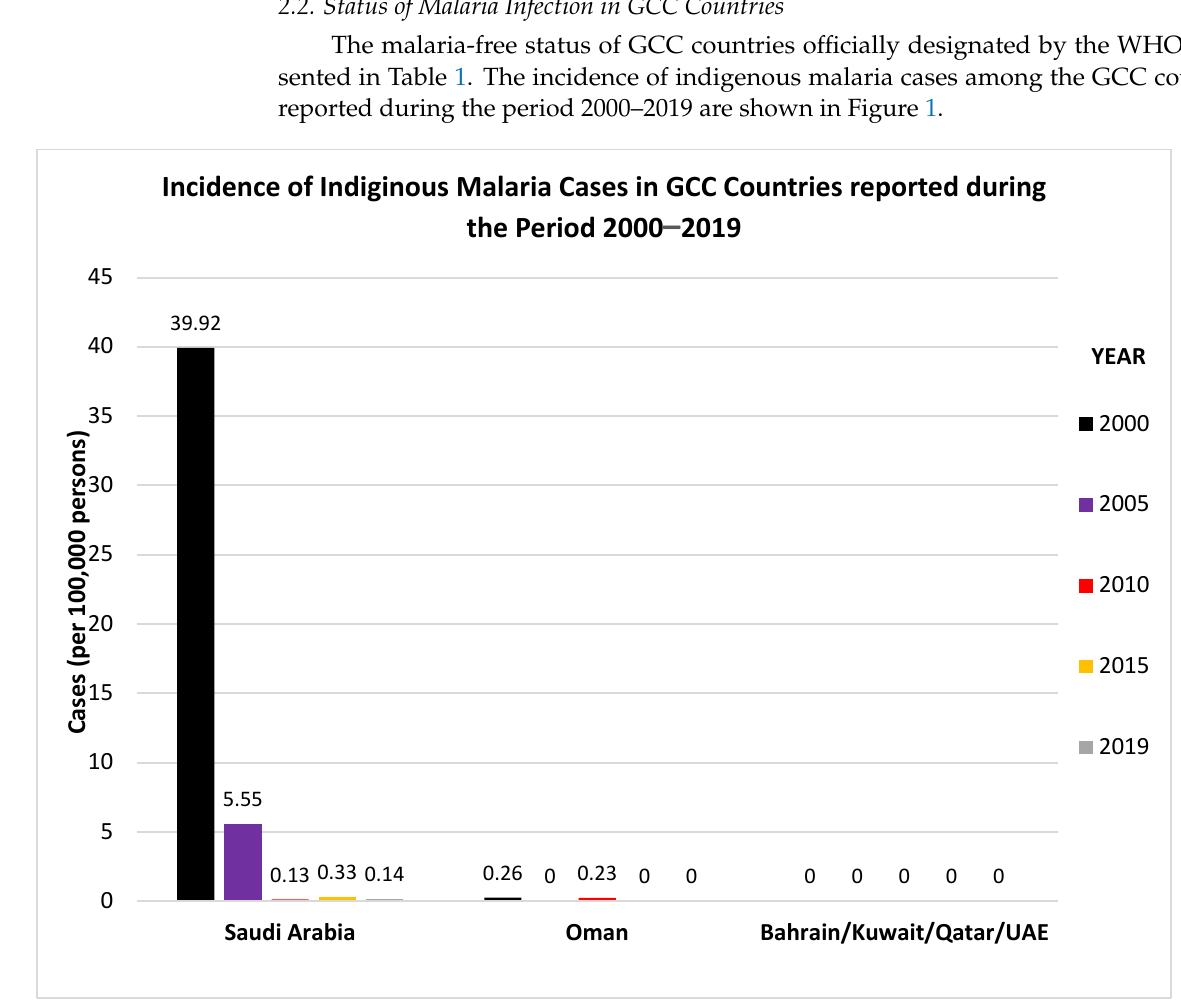
Table 1. An updated list of major malaria vectors and indigenous malaria status in GCC countries.